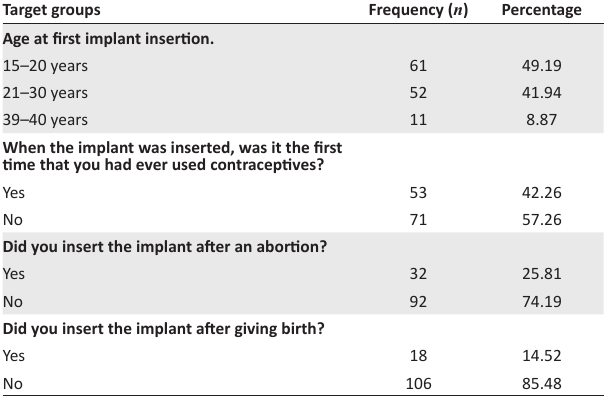
TABLE 4: Target groups suitable for implant use during pre-insertion